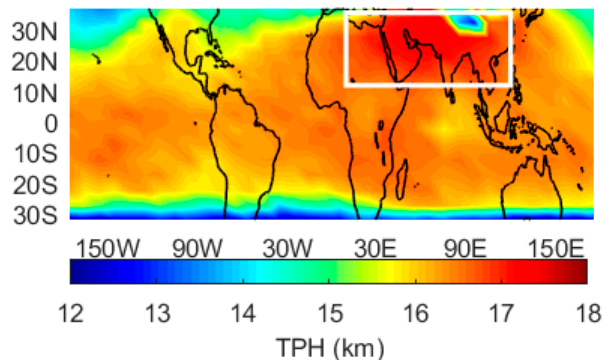
Figure 11. Seasonal pattern of tropical TPH for summer (June, July, August). White box is the same with that in Figure 10.